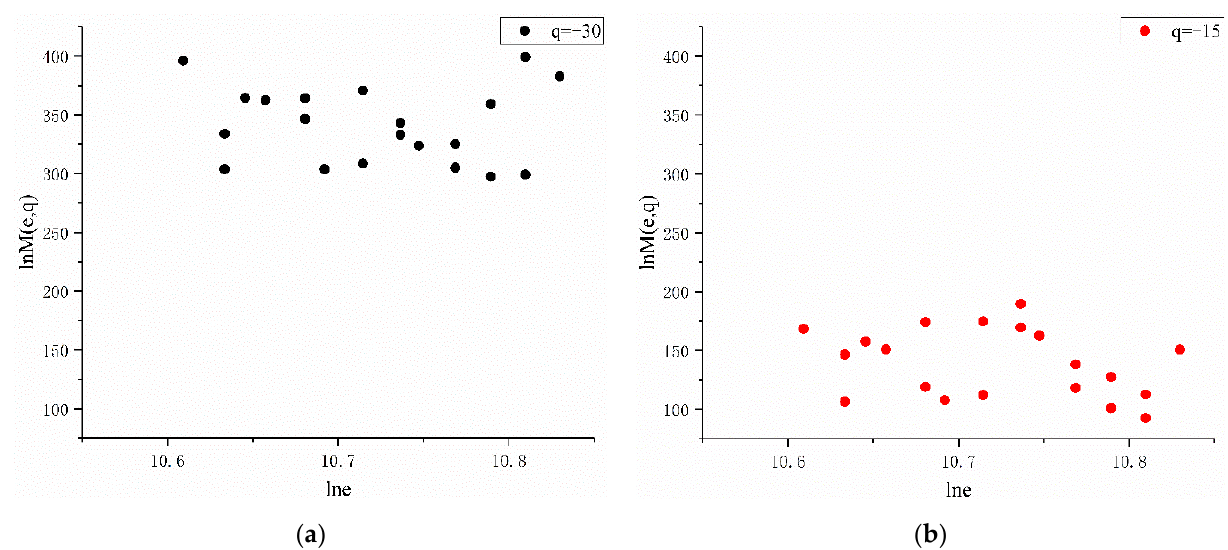
ISPRS Int. J. Geo-Inf. 2021 , 10 , x FOR PEER REVIEW Figure A1. The relationship of ln 𝑀(𝑒, 𝑞) and ln 𝑒 in the Yellow River Mainstream Basin. ( a ) The relationship of Figure A1. The relationship of ln M ( e , q ) and ln e in the Yellow River Mainstream Basin. ( a ) The relationship of ln M ( e , q ) and ln 𝑀(𝑒, 𝑞) and ln 𝑒 when e is [40,000, 50,000] and q is − 30; ( b ) The relationship of ln 𝑀(𝑒, 𝑞) and ln 𝑒 when e is [40,000, ln e when e is [40,000, 50,000] and q is − 30; ( b ) The relationship of ln M ( e , q ) and ln e when e is [40,000, 50,000] and q is − 15. 50,000] and q is − 15.